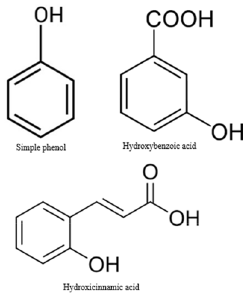
Figure 4: Chemical structure of simple phenol, HBA, and HCA.